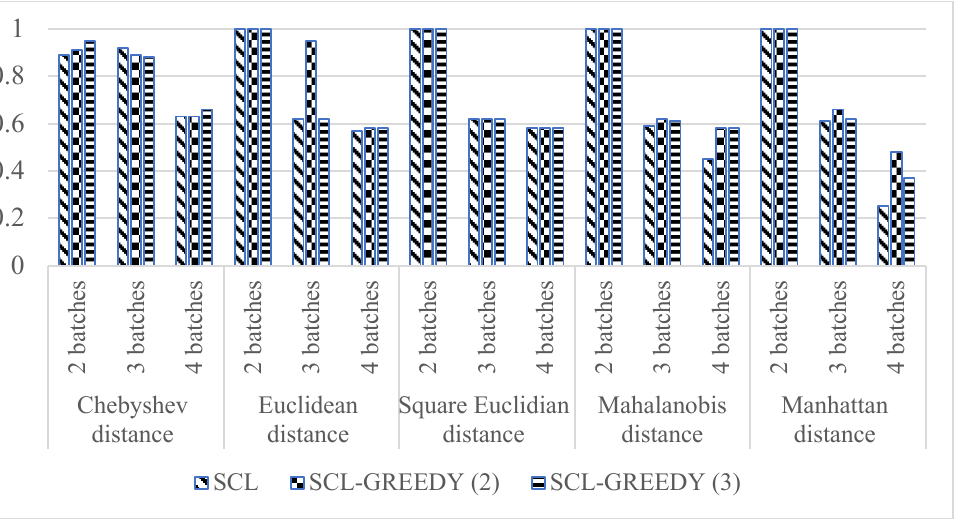
Figure 1. Accuracy of device clustering for SCL, SCL-GREEDY(2) and SCL-GREEDY(3) algorithms. With regard to the influence of the distance measure on the clustering accuracy, it can be noted that the Chebyshev distance has an advantage over the others except two-batch mixed lot. However, in the case of the Chebyshev distance, we were dealing with a large coefficient of variation and a span coefficient for 3 and 4 mixed lots. Moreover, for various combinations of batches, the minimum (Min), maximum (Max), mean (Mean), standard deviation ( σ ), coefficient of variation (V) and the span factor (R) of the objective function are calculated (Tables 1–5, Figure 2).